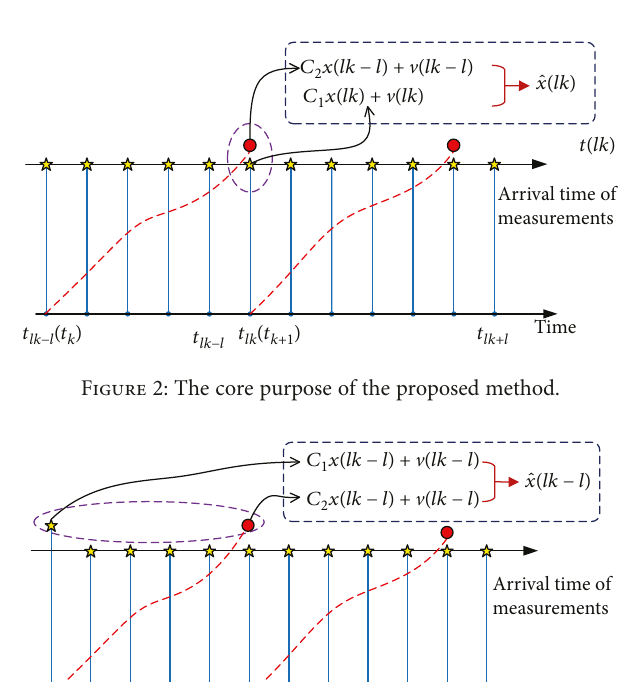
Figure 3: Calculate the x